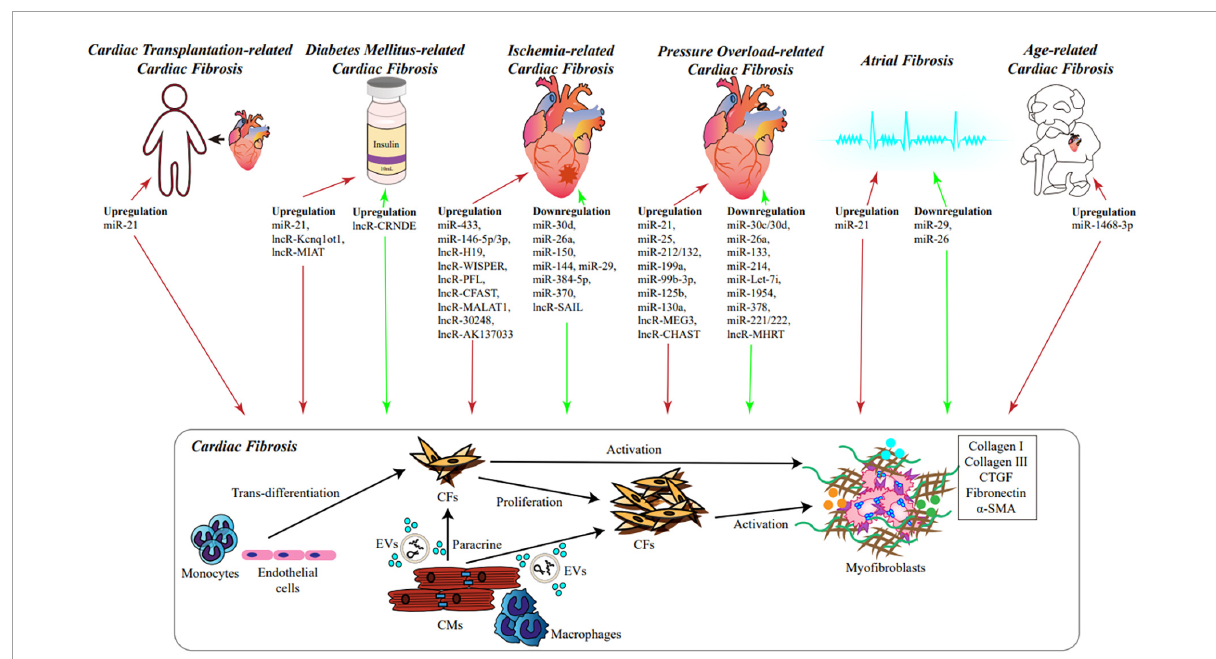
FIGURE1 The role of NcRNAs in cardiac fibrosis. During various cardiac diseases and heart aging, significant alteration of cellular transcriptome takes place in cardiac tissues, including ncRNAs, especially miRNAs and lncRNAs, which could influence the process of cardiac fibrosis. Under stimulation, monocytes and endothelial cells can trans-differentiate into CFs; ncRNAs and cellular factors derived from CMs and macrophages could be secreted into EVs or released to extracellular microenvironment, and absorbed by CFs; expression of ncRNAs in CFs can be changed as well. Consequently, CFs would proliferate and differentiate into myofibroblasts via different signaling pathways. Myofibroblasts secrete a large amount of ECM, which leads to cardiac fibrosis eventually. Red arrows represent promoting fibrosis, green arrows represent inhibiting fibrosis. ncRNAs, non-coding RNAs; miRNAs, microRNA; lncRNAs, long non-coding RNAs; CMs, cardiomyocytes; CFs, cardiac fibroblasts; EVs, extracellular vesicles; ECM, extracellular